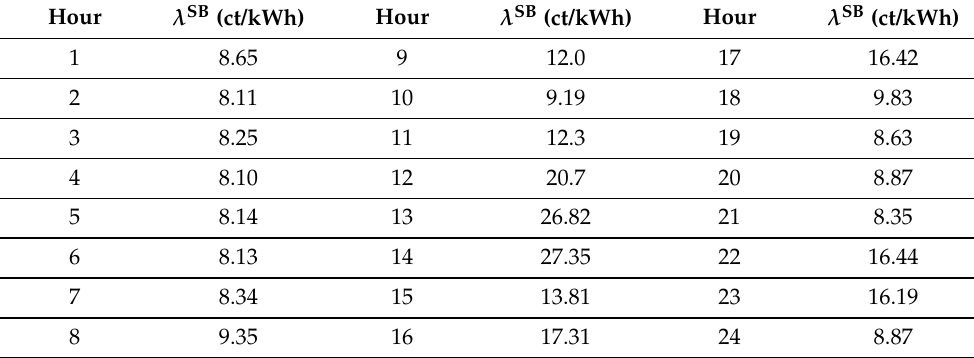
Table 4. Utility rates.